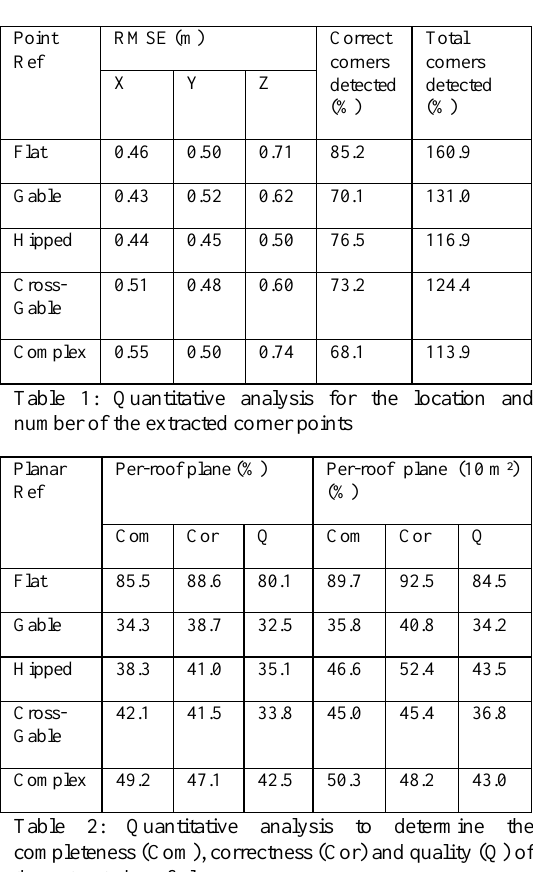
Figure 7. Results of LoD2 reconstruction for (a) a flat roof and (b) a complex roof structure.